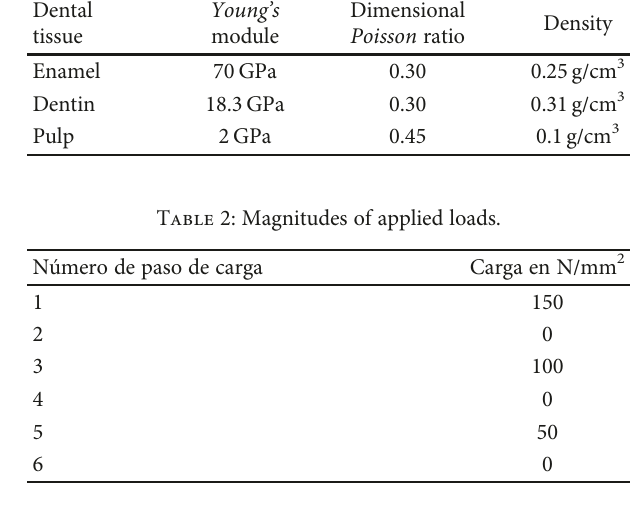
Figure 2: Fractures produced by the action of horizontal and lateral occlusal loads. (a) Normal forces acting during mastication. (b) Parafunctional forces.